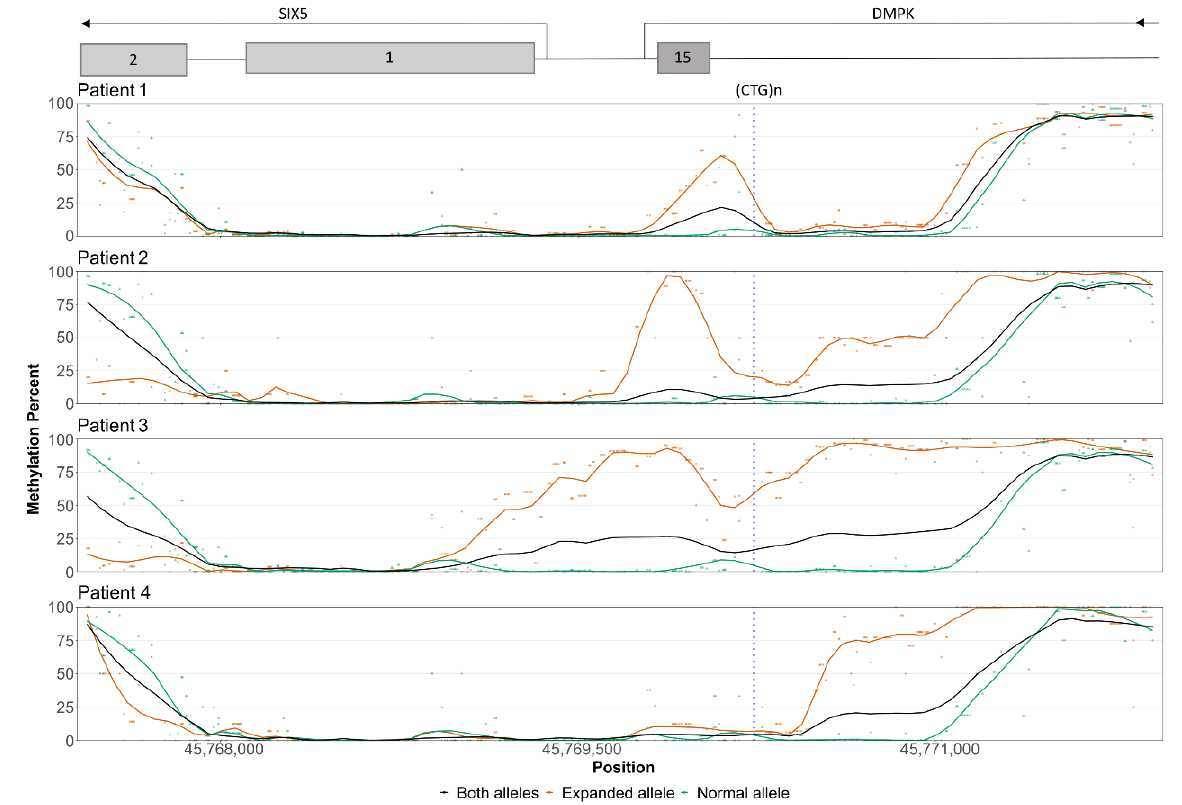
Figure 5. Allele-specific methylation profiles of the patients. The y-axis represents the methylation level in percent and the x-axis represents the genomic position. The vertical blue stippled line indicates the position of the CTG repeat and the positions of nearby genes are indicated at the top of the plot. The average methylation level of all reads is shown by the black line. The healthy alleles (green dots and lines) of the patients display methylation levels similar to the controls. In patient 1, the disease allele (orange dots and lines) is hypermethylated downstream of the repeat, while slightly increased methylation levels upstream of the repeat are also apparent in the disease allele. In patient 4, slight hypermethylation downstream of the repeat can be seen with the allele-specific analysis in addition to the upstream hypermethylation. Patients 2 and 3 have a disease allele that is hypermethylated both upstream and downstream of the repeat. All patients display hypomethylation of the disease allele towards the downstream end of the CpG island. The dots represent individual data points, while the lines are the smoothed data.